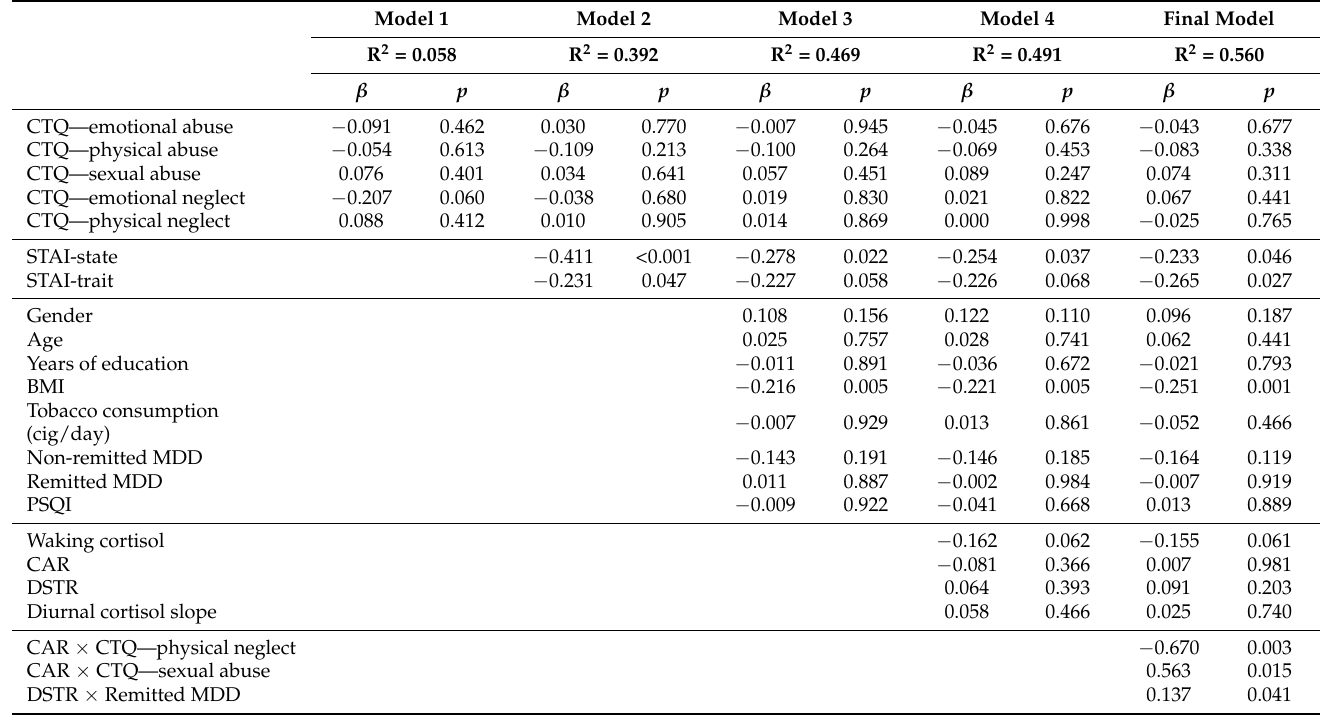
Table 2. Results of multiple linear regression analyses exploring the association of childhood maltreatment, hypothalamic– pituitary–adrenal (HPA) axis function, and MDD remission status with disability (SASS) in all participants ( n =